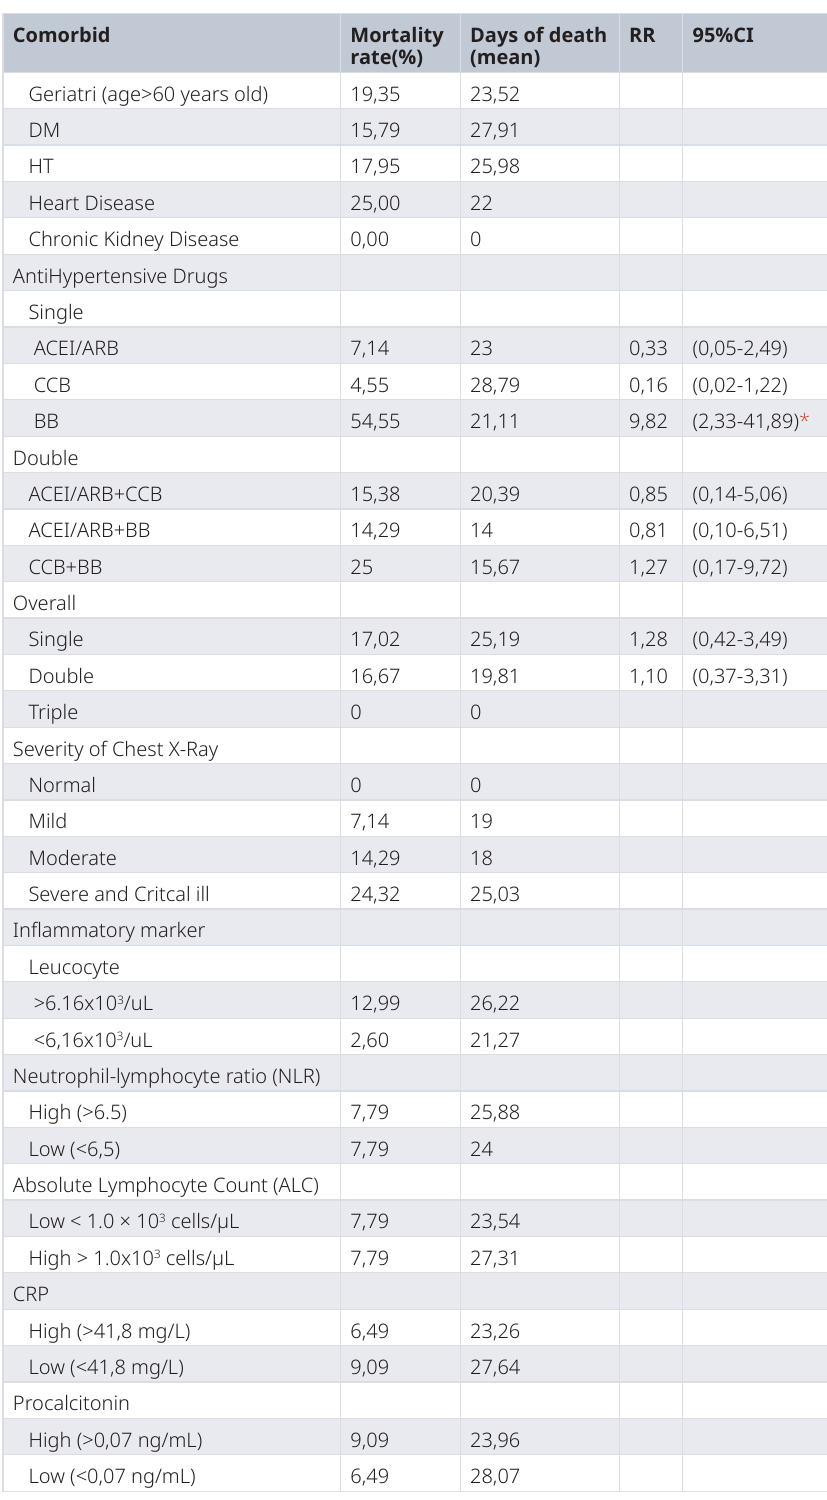
Table 3. Disease progression among anti-hypertensive drugs. ACEI/ARB: angiotensin- converting enzyme inhibitors and angiotensin receptor blockers; CCB: calcium channel blocker; BB: beta blocker; CI: confidence interval. Comorbid Mortality Days of death RR 95%CI rate(%) (mean) Geriatri (age>60 years old) 19,35 23,52 DM 15,79 27,91 17,95 25,98 Heart Disease 25,00